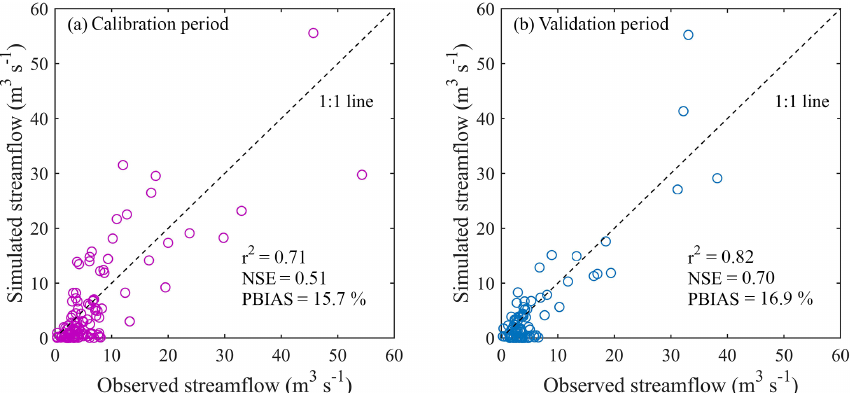
Figure 3. Model performance for the (a) 10-year (1983–1992) calibration period and the (b) 8-year (1993–2000) validation